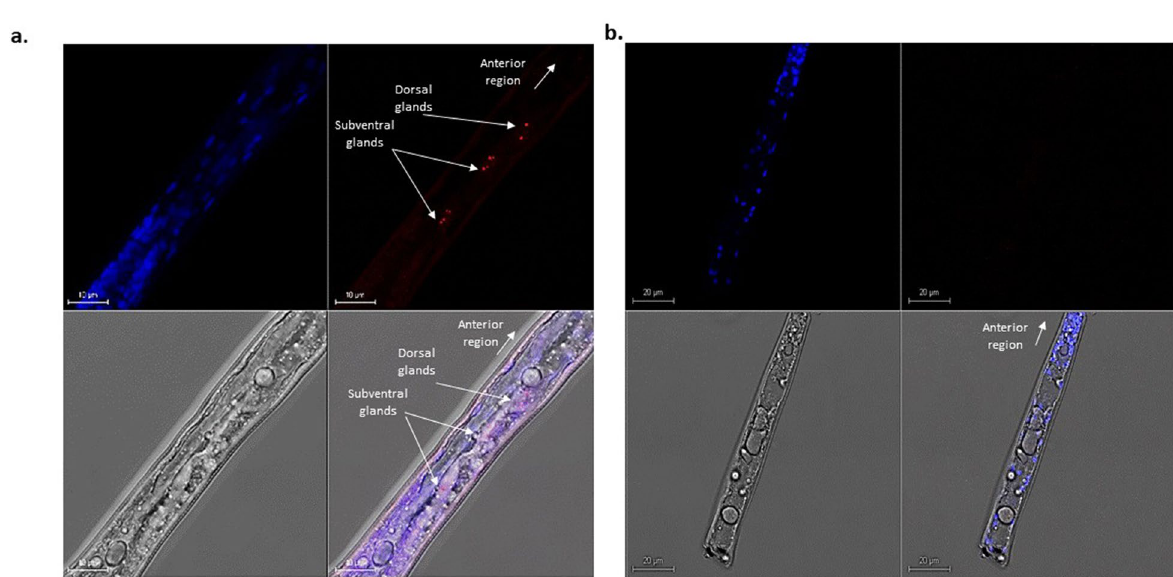
Figure 3. Localization of MjMCM2 mRNA using a gene-specific MjMCM2- Cy5 cDNA-labeled probe (red) visualized in dissected M. javanica juvenile nematodes exposed to the oxylipin 9-HOT. M. javanica J2s were counterstained with DAPI (nuclei; blue). ( a ) J2s exposed to oxylipin 9-HOT and then subjected to FISH. MjMCM2 mRNA fluorescence was visualized by fluorescence microscopy. Top: DAPI staining (left) and hybridization signal in red indicated by arrows (right). Bottom: M. javanica visualized by differential interference contrast (DIC) microscopy (left) and overlaid images with DAPI staining and hybridization signal (right). ( b ) Control J2s were subjected to FISH in 0.01 M MES buffer without exposure to 9-HOT, resulting in no hybridization signal. Samples were visualized under an IX81Olympus FluoView500 confocal microscope. Scale bar = 20